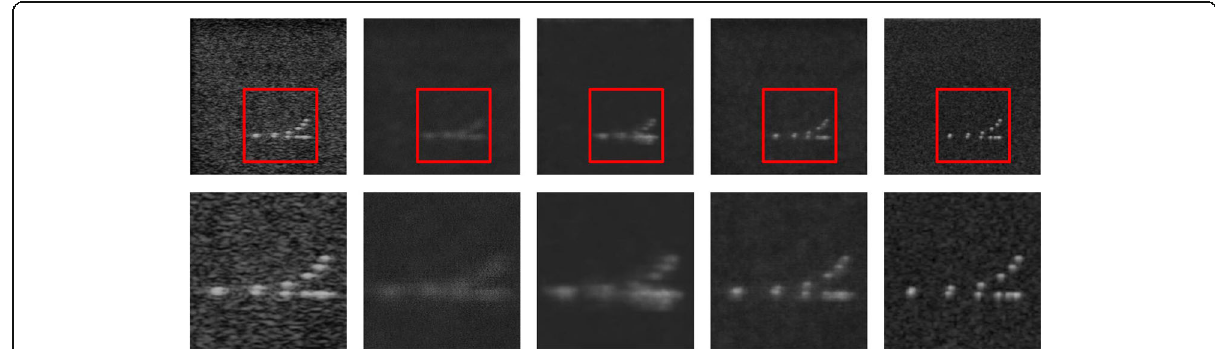
Fig. 6 Result examples of cyst phantom images. On the first line from left to right are low-quality image, encoder-decoder result, U-Net result, SSC U-Net result, and high-quality image correspondingly. The second line shows the image in the corresponding red box in the first line